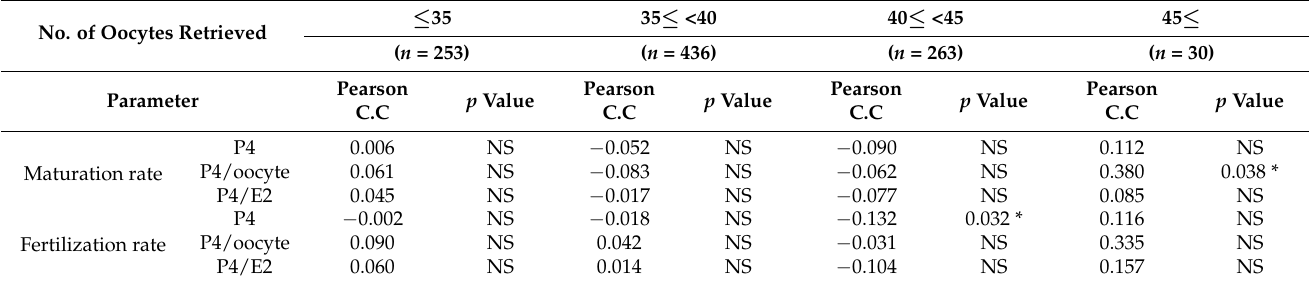
Figure 4. Correlation between serum P4 level on the day of hCG administration and the rates of good-quality embryo (GQE) at the cleavage stage ( A ) and the blastocyst stage ( B ) ( p < 0.05(*), p < 0.01(**), p < 0.001(***). Table 3. Correlation analysis of parameters related to P4, P4/oocyte and P4/E2 according to pa- tient’s